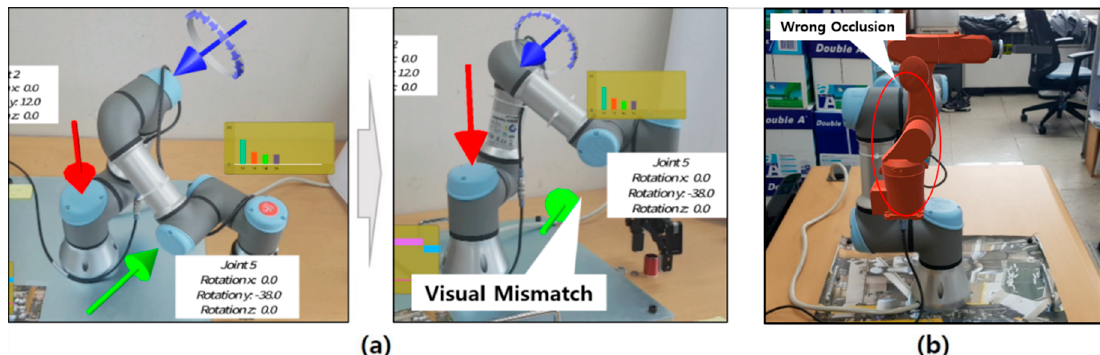
Figure 1. Visualization problems in conventional industrial AR systems: ( a ) visual mismatch occurs when the physical configuration of the robot is changed; ( b ) undesired occlusion occurs when the depth perception of physical and virtual objects cannot be properly estimated (the virtual object is located behind the real robot.).